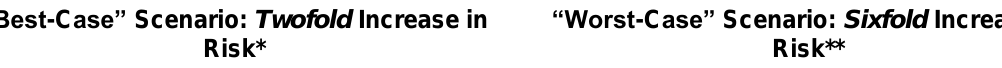
Competing Assumptions Leading to the Calculation of the Two Ends of the Plausible Range for the Increase in the Risk of TTIs Secondary to Transfusion of PWBD (Rather than Single-Donor)